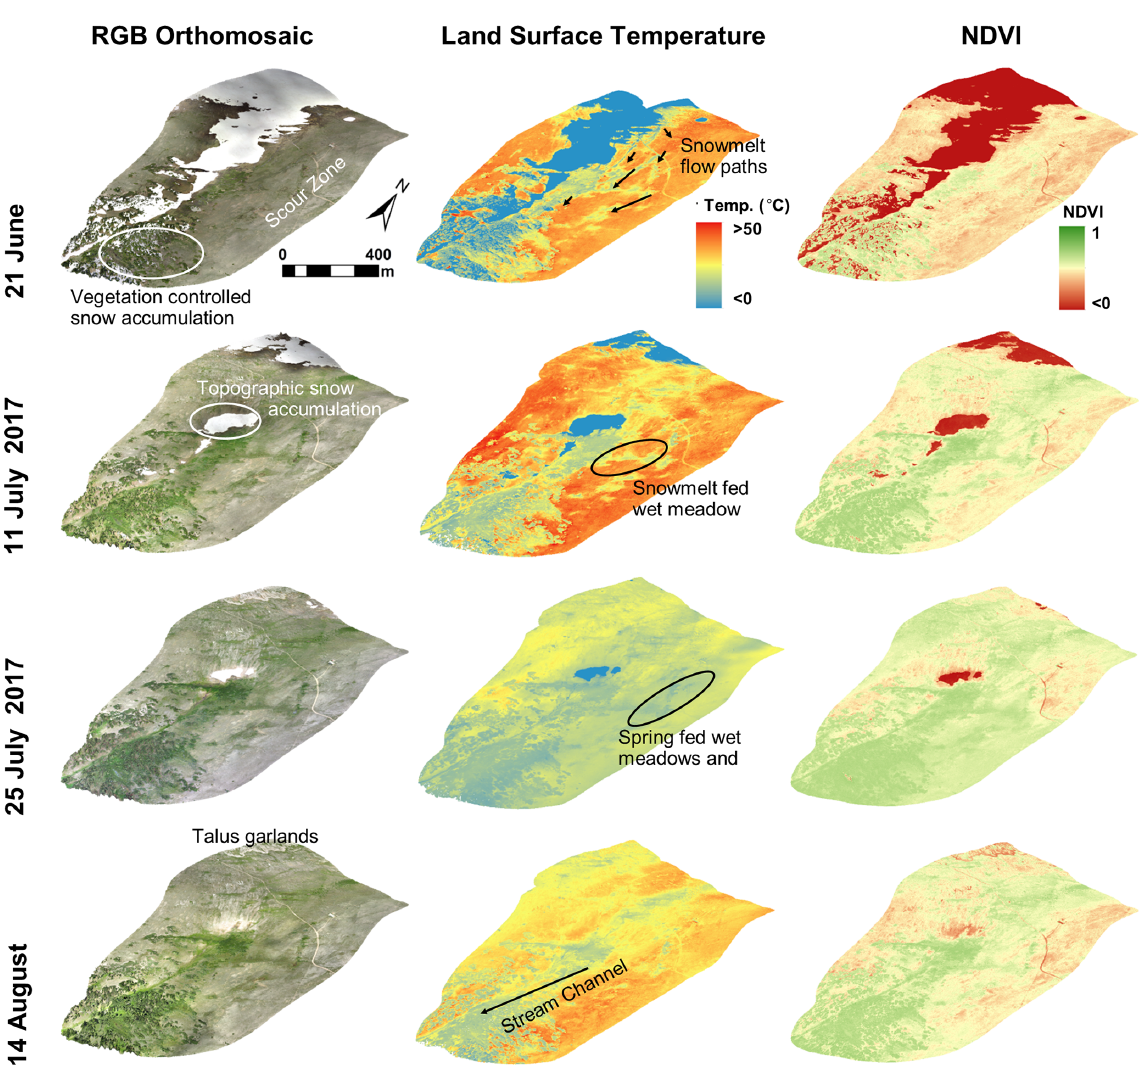
Figure 5. Three-dimensional views of selected RGB orthomosaics (5cm), T s maps (from TIR) (25cm), and NDVI (25cm) draped over the 14 August 10cm